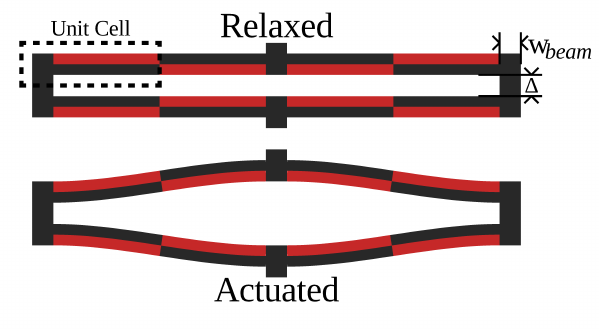
Figure 2. Unactuated and actuated composable s-drives.